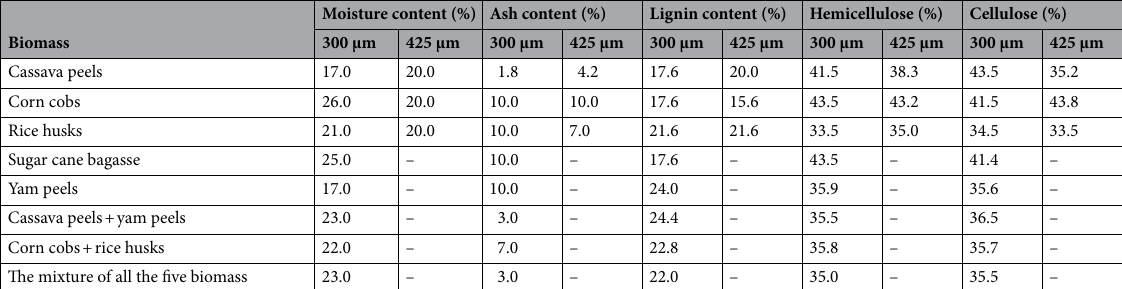
Table 4. Proximate analysis result for hydrothermal only pretreated